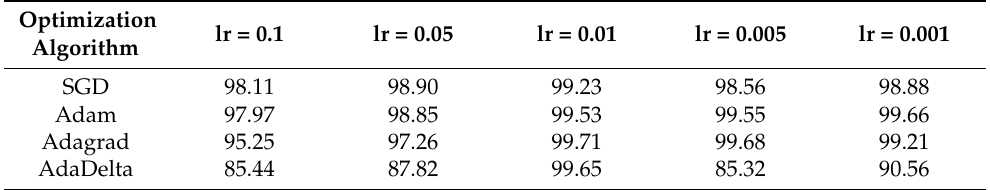
Table 3. Recognition accuracy (%) of RiceDRA-Net on SBG-Dataset under different optimization algorithms and learning